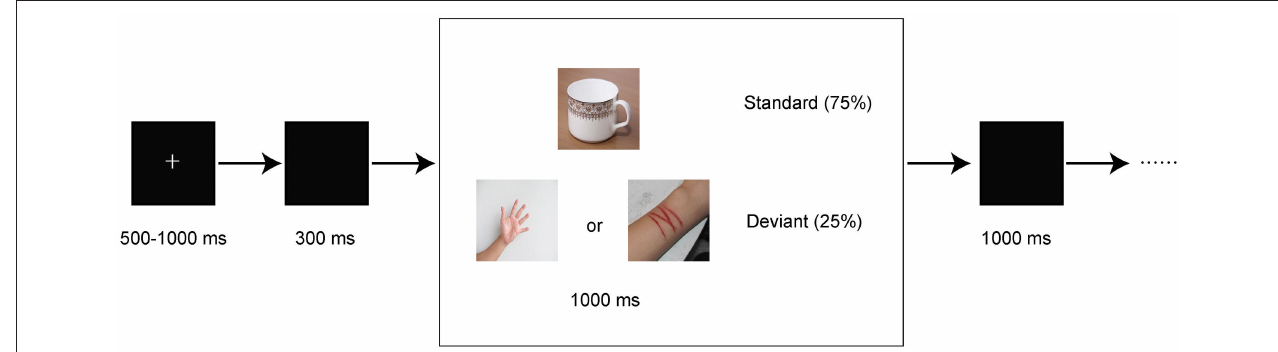
FIGURE 1 | Schematic illustration of the experimental procedure and example stimuli. Each trial presented a single deviant or standard stimulus. Subjects pressed the “1” or “2” keys to respond to standard or deviant stimuli,